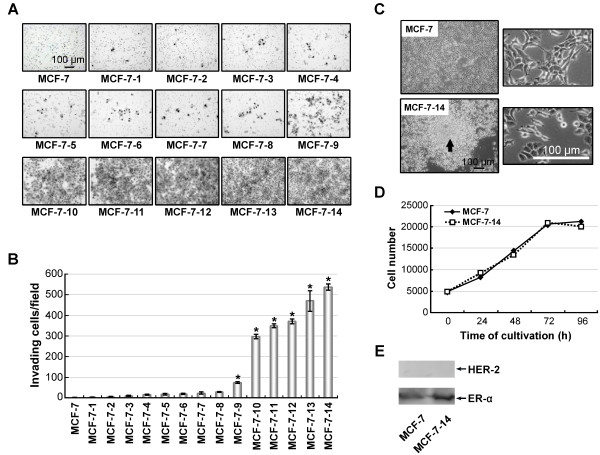
In vitro sequential selection of invasive populations from MCF-7 cells using Matrigel Invasion Chambers. (A and B) In each cycle, cells invading the Matrigel were fixed with 10% formalin-neutralized buffer and stained with crystal violet on the underside of the chamber (A), and then the numbers of invading cells were counted under a microscope (B). Data are the means ± SD (n = 3). Statistical analysis was performed by Student's t test. *, P < 0.01, compared with MCF-7 cells. (C) Images of morphology of MCF-7 and MCF-7-14 cells in culture. MCF-7-14 cells were propagated as non-adherent spheres (arrow). (D) Proliferative rates of MCF-7 and MCF-7-14 cells. (E) Western blotting analysis for the expression of HER-2 and ER-α in MCF-7 and MCF-7-14 cells.